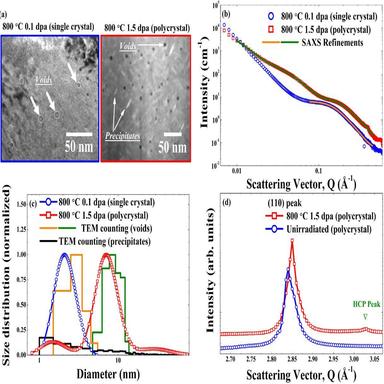
(a) bright-field and high-angle annular dark-field TEM images for neutron irradiated single crystal and polycrystalline W specimens (modified from,); (b) corresponding background corrected SAXS patterns with refinements overlaid (solid orange and green lines); (c) void and particle size distributions recovered from the SAXS refinements and TEM counting; (d) XRD patterns for unirradiated and neutron irradiated W.